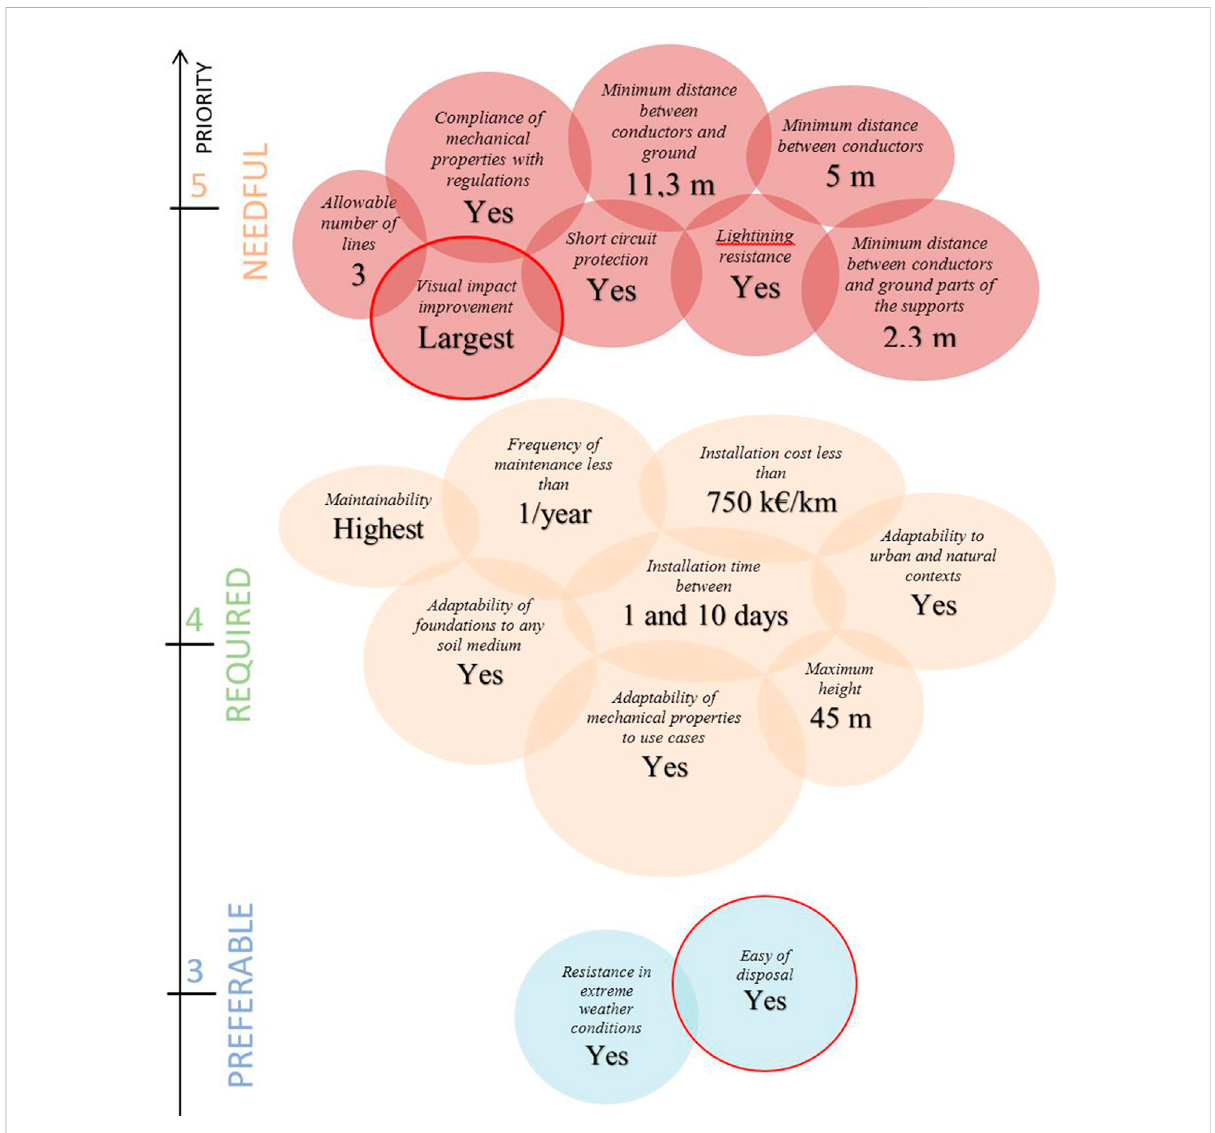
FIGURE 5 Technical speci fi cations for a pylon of a 380-kV electricity